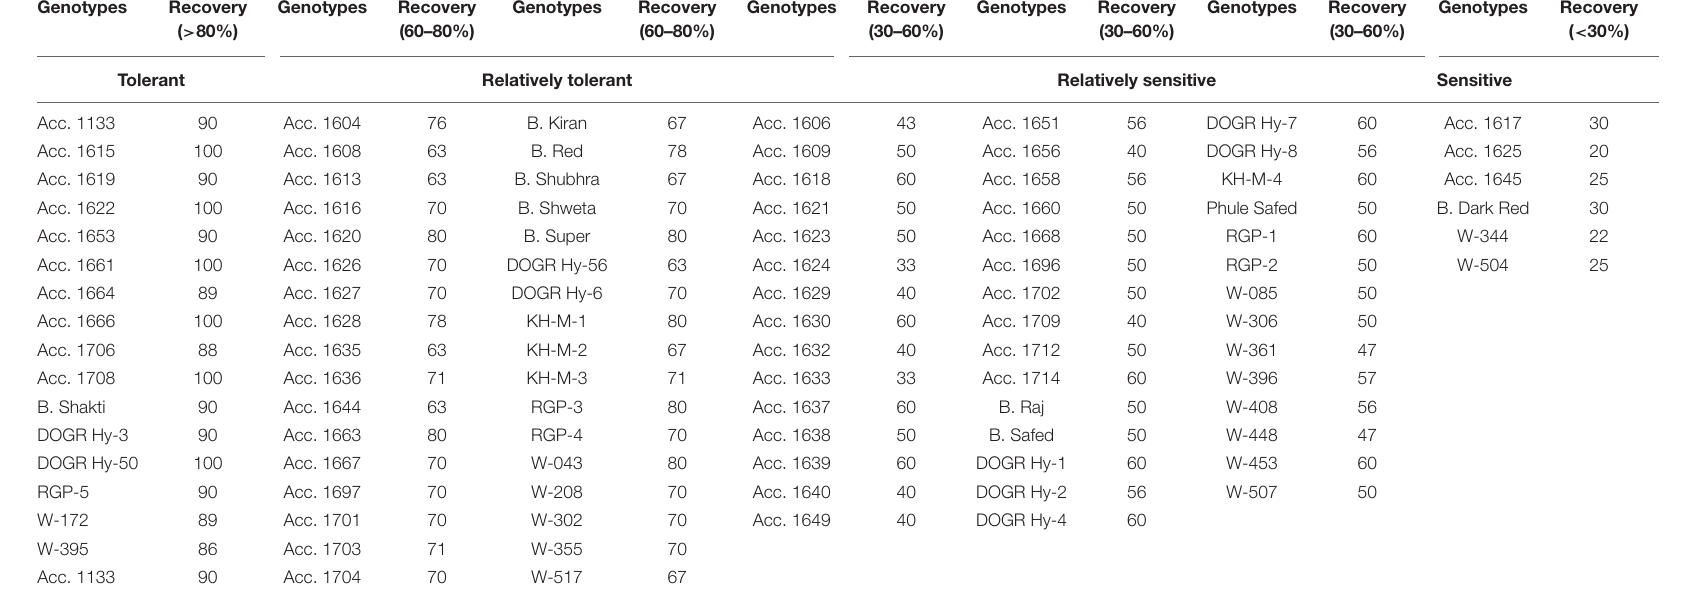
TABLE 2 | Genotypes grouped based on plant waterlogging stress recovery percentage.